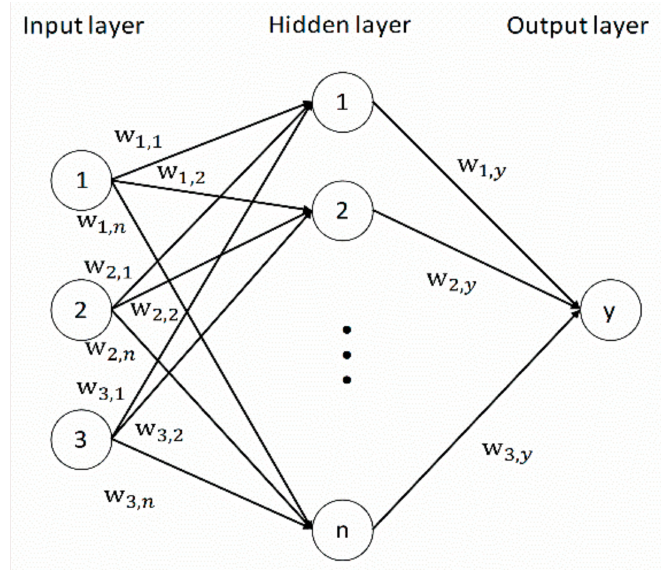
Figure 3. Basic structure of three-layer neural